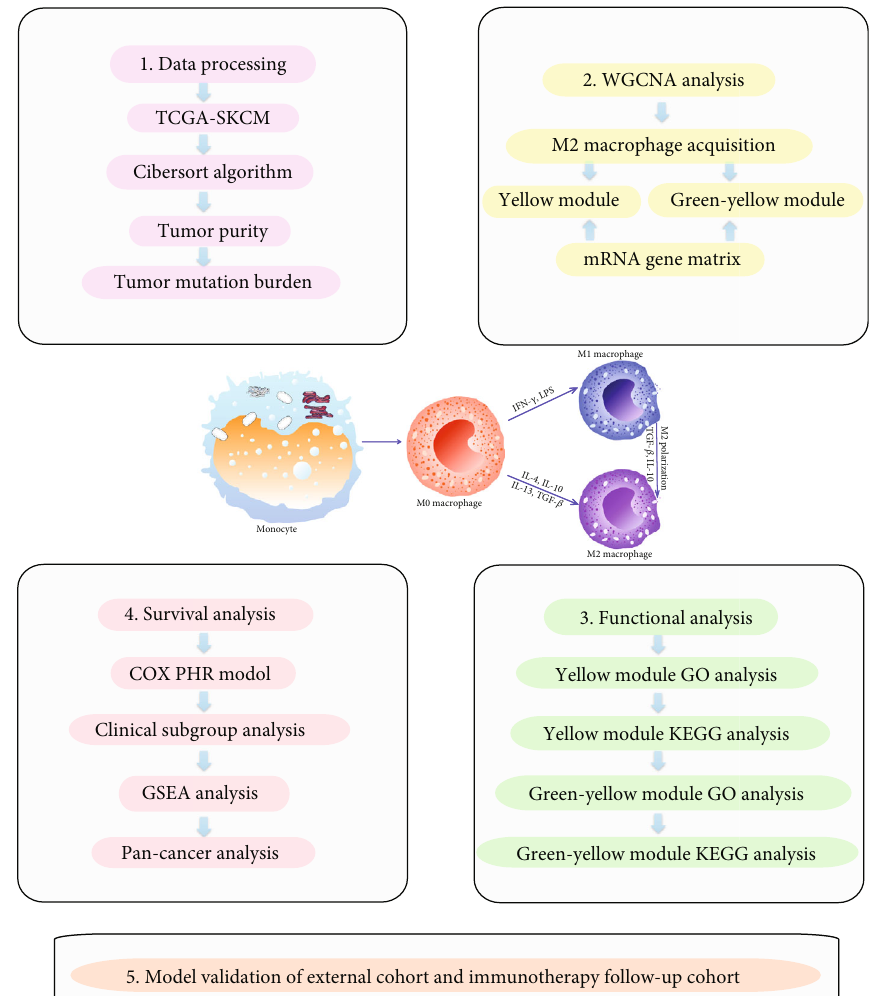
Figure 1: Flow chart to identify coexpressed genes that promote M2 macrophage in fi ltration in melanoma. (1) Data processing: 470 melanoma tissue samples were obtained from SKCM-FPKM. CIBERSORT algorithm was used to calculate M2 macrophage in fi ltration in melanoma tissue samples. Then, the tumor purity and mutation burden in the tumor immune microenvironment were analyzed. (2)WGCNA analysis: WGCNA was used to generate a coexpressed gene network to obtain coexpressed genes. Combined with the analysis of M2 macrophage content and mRNA gene matrix, the yellow module with the most negative correlation to M2 and the green-yellow module with the most positive correlation were selected. (3) Enrichment analysis: GO analysis and KEGG analysis were performed on the yellow module and the green-yellow module. (4) Survival analysis: the genes screened by WGCNA were analyzed for survival. According to these results, establish the Cox Proportional Regression model based on multiple factors and screen out the model ’ s essential critical genes. TCGA-SKCM clinical subgroup analyses were performed on the prognostic model. GSEA analysis and pan-cancer analysis were performed on the essential genes. (5) Model validation: a prognostic scoring model related to the coexpression genes of M2 macrophages in melanoma was validated in the GSE69504 cohort and GSE78220 with immunotherapy follow-up